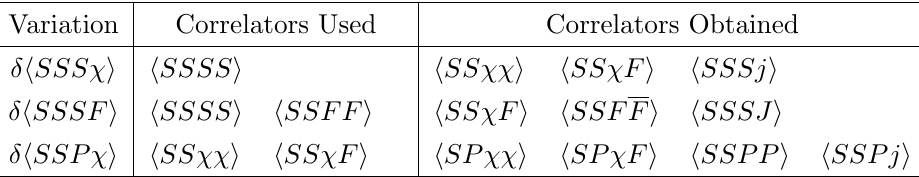
Table 6 . Taking supersymmetric variations to compute correlators. By setting the variation in the (cid:12)rst column to zero, we can use the correlators in the second column to compute the correlators in the third column. For each correlator we only compute the P and Z invariant structures. In the table we have not included correlators involving F which are related to those with F by Hermitian